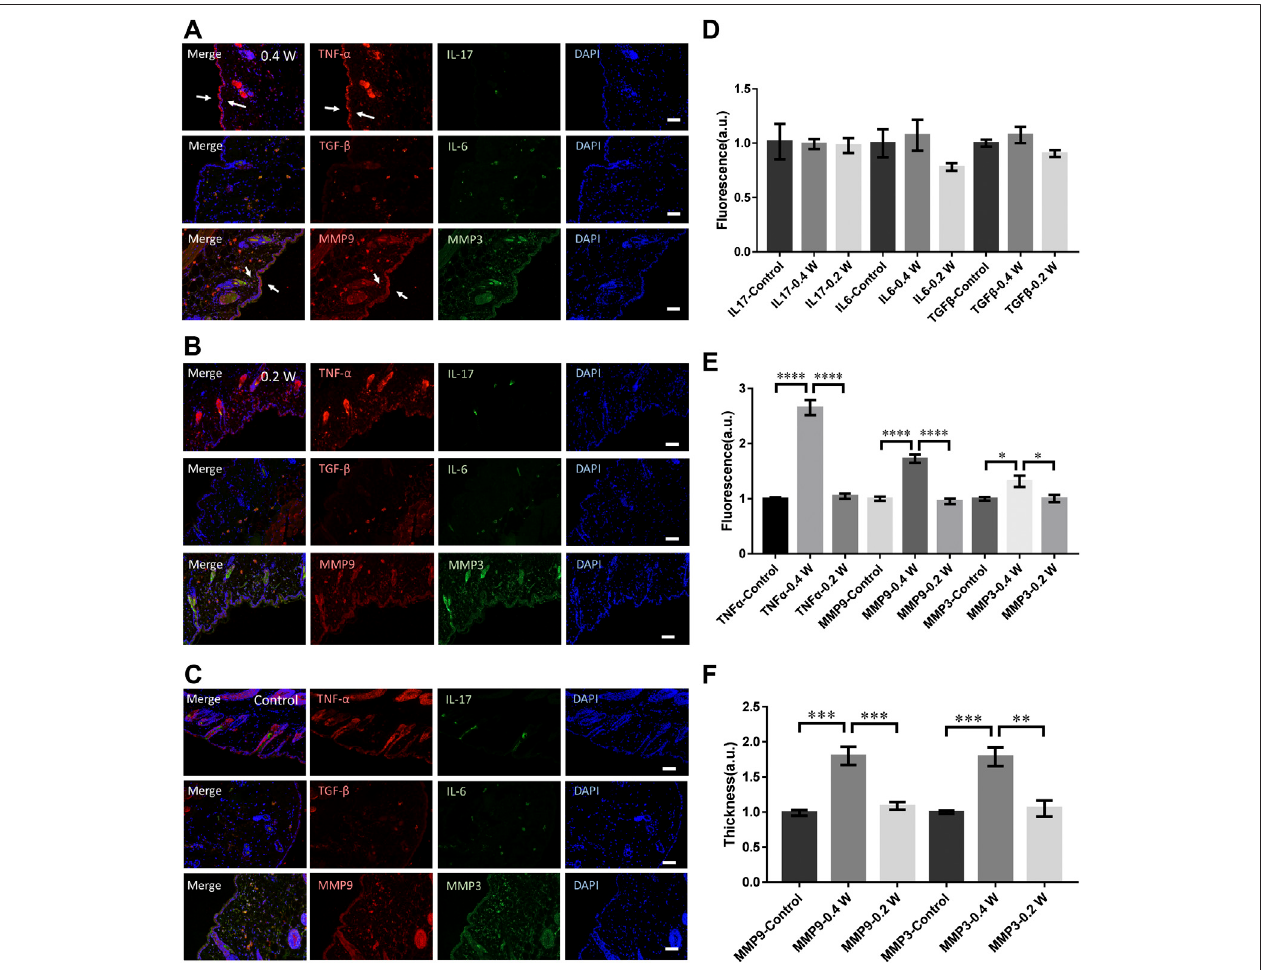
FIGURE2| Molecular responsesofskintofemtosecond-lasermicromachiningat0.4 W (A) and0.2 W (B) respectively. (C) negativecontrol. (D) Statisticresultsof the fl uorescence intensity of IL-17, IL-6, and TGF- β in the experimental and control groups (n (cid:1) 24 samples from six independent trails). Statistic results of the fl uorescence intensity (E) and skin thickness (F) of TNF- α , MMP3, and MMP9 in the experimental and control groups respectively (n (cid:1) 24 samples from six independent trails). Bar: 100 μ m. * p < 0.05. ** p < 0.01. *** p < 0.001. **** p < 0.0001, by students ’ t-test .